Question: Provide a publication-style caption for this figure.
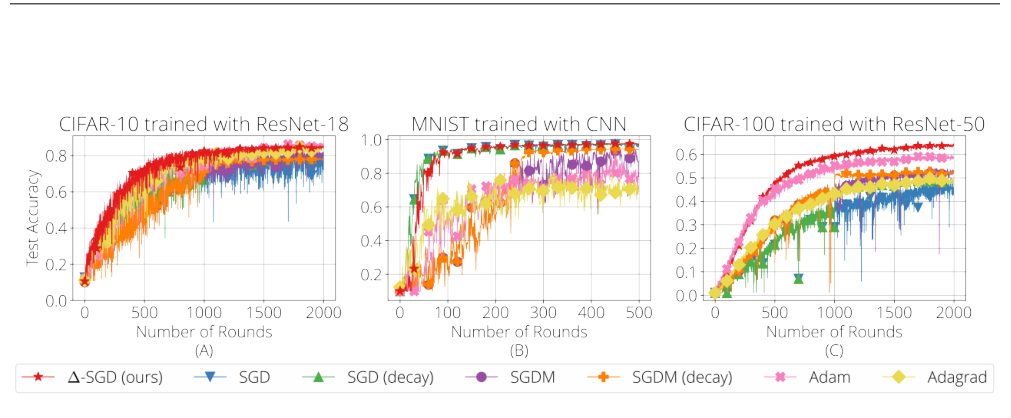
Answer: Illustration of the effect of not properly tuning the client step sizes. In (A), each client optimizer uses the best step size from grid-search. Then, the same step size from (A) is intentionally used in settings (B) and (C). Only ∆-SGD works well across all settings without additional tuning.